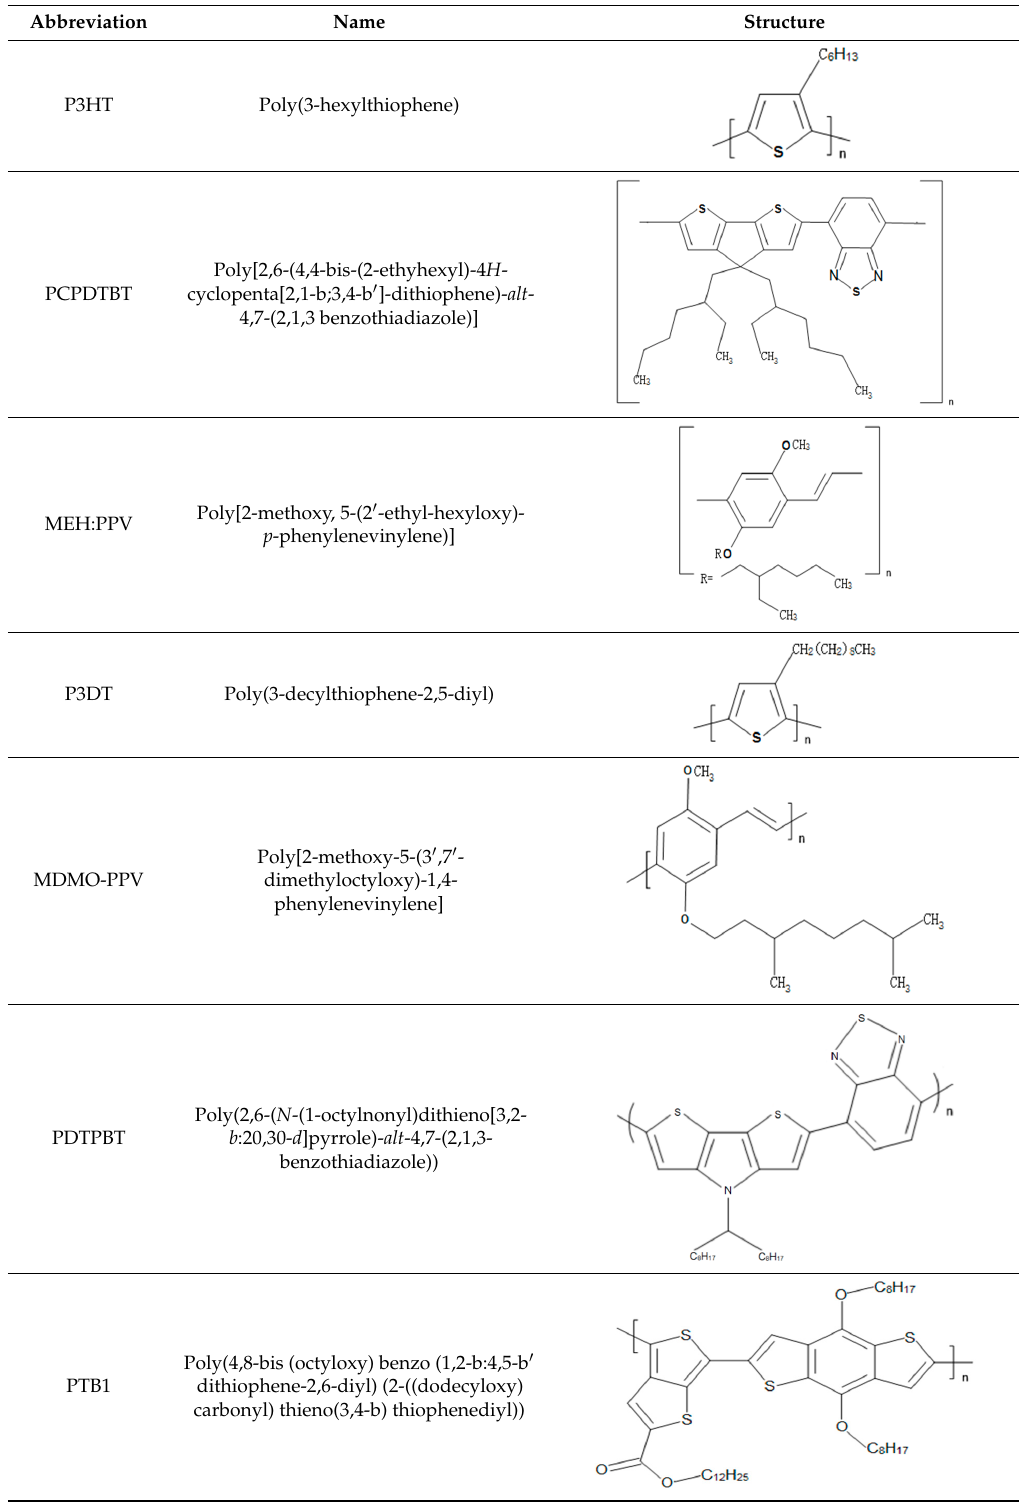
Table 1. Common CPs used in BHJ solar cells.